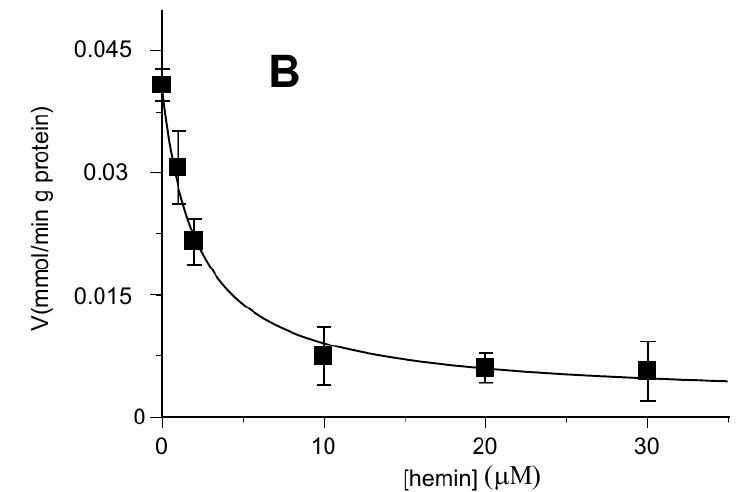
Figure 2. Hemin inhibition of the OGC-mediated uptake of [ 14 C] 2-oxoglutarate and [ 14 C] malate. The transport rate of [ 14 C] 2-oxoglutarate in homo-exchange ( A ) or [ 14 C] malate in hetero-exchange ( B ) was measured in 2 min in the absence and in the presence of increasing concentrations of hemin (1–30 µM). Hemin was added together with [ 14 C] 2-oxoglutarate or [ 14 C] malate at a concentration of 0.05 mM to proteoliposomes containing 6 mM of 2-oxoglutarate. Values are means ± S.D. from three independent experiments.